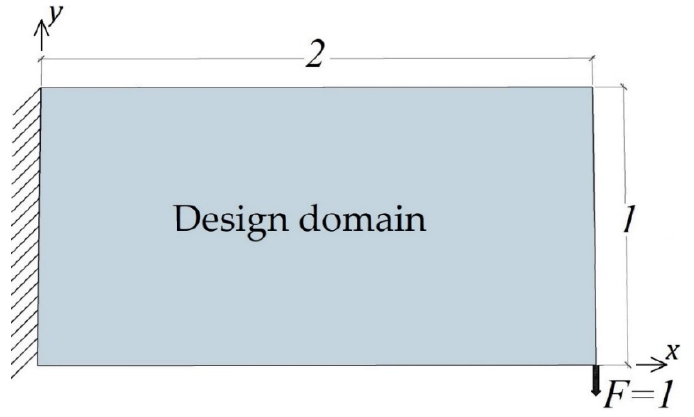
Figure 4. Problem definition of the cantilever plate (case 2): design domain, loading, and supports.